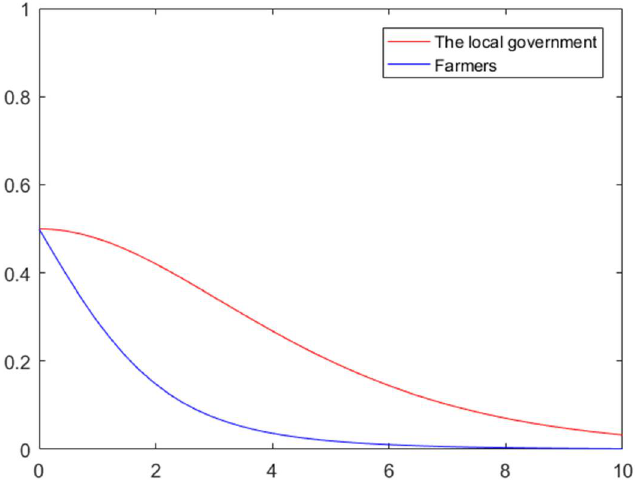
Figure 10. Simulation results at the fourth stage ( ∆ S 1 = 3.5, I 4 = 1, ∆ S 2 = 2.5 ).